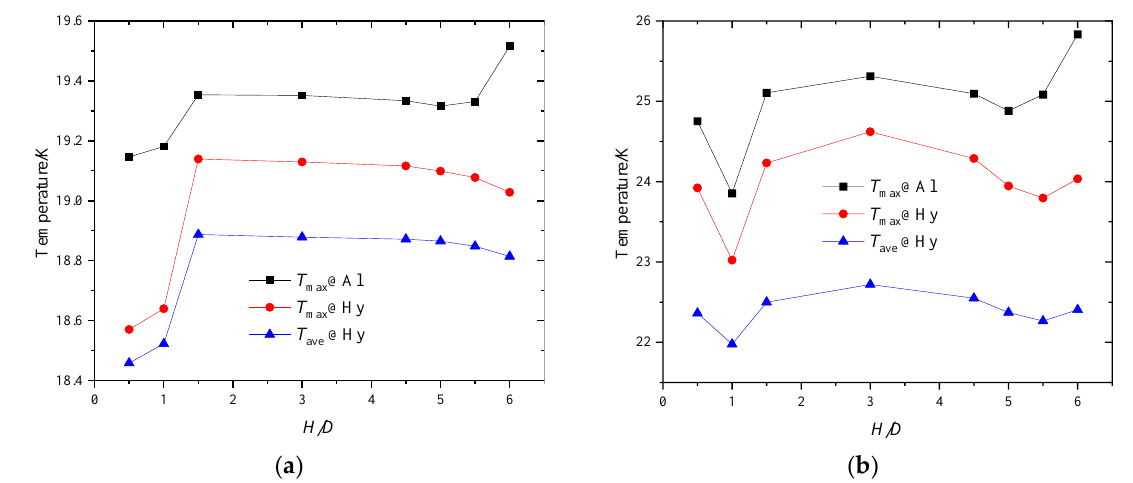
Figure 14. The maximum temperature varies with H/D under different power: ( a ) Beam power = 100 kW; ( b ) Beam power = 500 kW.